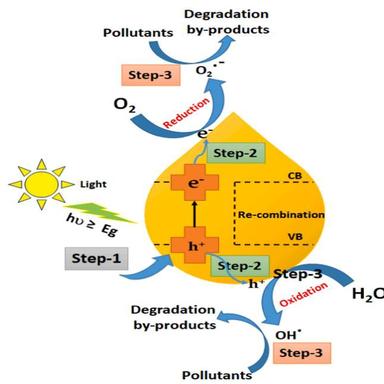
Schematic overview of a photocatalytic process used for the degradation of organic pollutants.